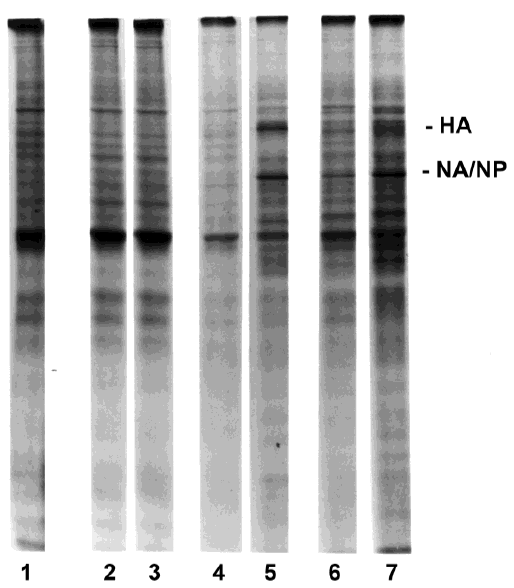
Figure 5. Influenza virus infection of purified resting and proliferating lymphocytes. Autoradiograms of purified human lymphocytes that were sham-exposed (lane 1) or exposed to influenza virus (lanes 2–7) in the presence of autologous monocytes-macrophages are shown. The lymphocytes were then purified by elutriation before radiolabeling. The lymphocytes had been cocultured with varying proportions of monocytes-macrophages for three days after stimulation with inactivated influenza virus as follows: <0.5% monocytes-macrophages, lanes 2 and 3; 11% monocytes-macrophages, lanes 4 and 5; 26% monocytes-macrophages (equivalent to unseparated PBMC), lanes 1 (control), 6, and 7. Cells were then exposed to infectious influenza virus, followed by purification by elutriation, with separation into resting and proliferating fractions before radiolabeling. As with the other figures, each lane represents lysate from 2 × 10 6 cells. Lanes 2, 4, and 6 show lysates from small resting lymphocytes ( ▲ in Figure S3 and Figure 4; >95% G 0 /G 1 ). Lanes 3, 5,